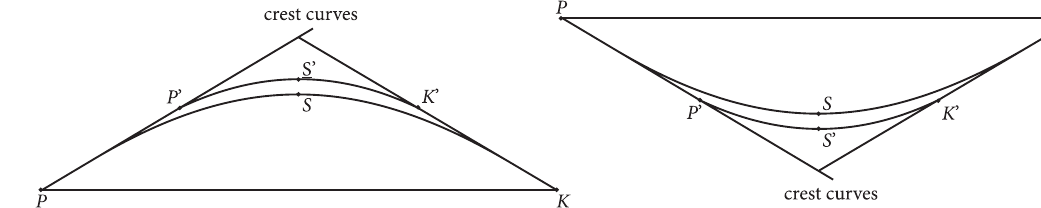
Fig. 1. Two types of vertical arcs: parabolic (P’S’K’) and formed by transition curves (PSK) (Kobryń